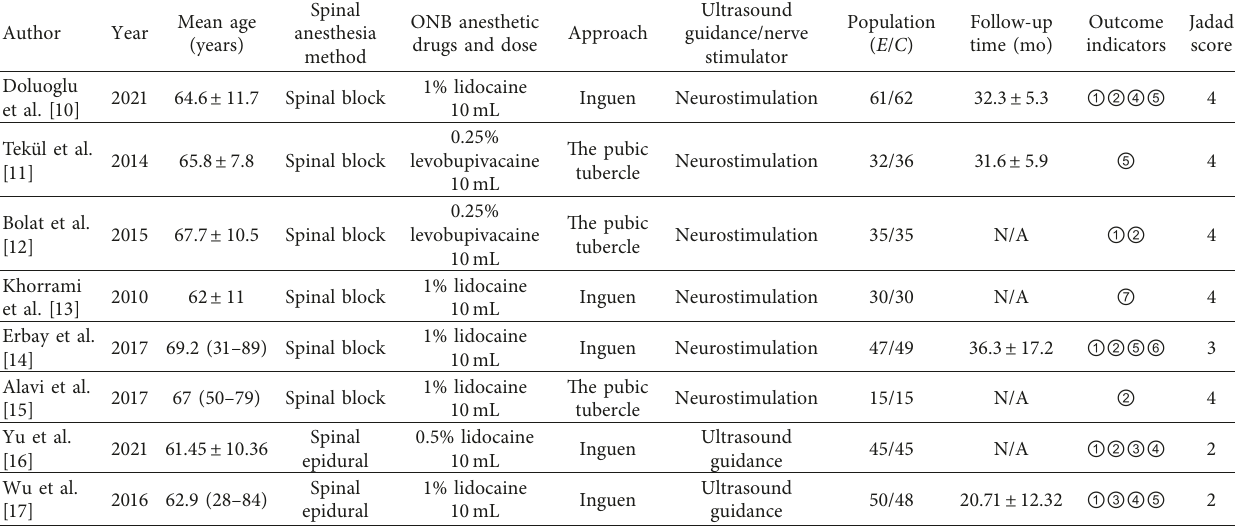
Table 1: Basic characteristics, intervention measures, outcome indicators, and quality scores of the included